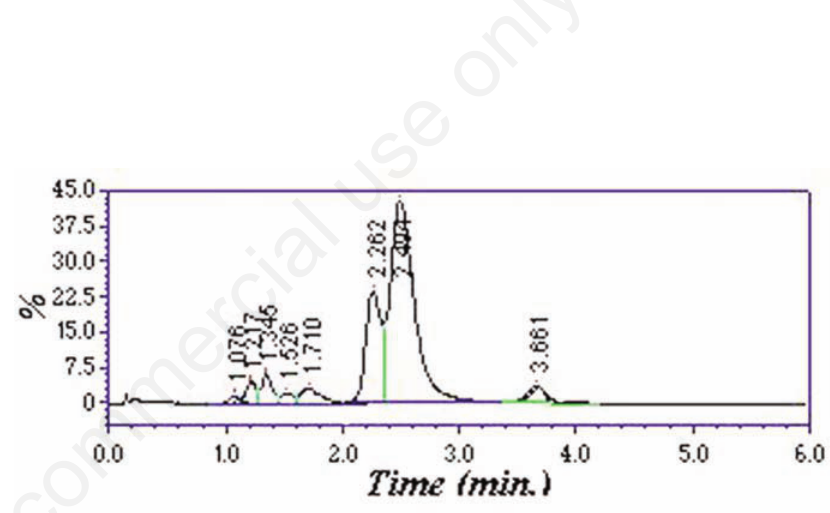
Figure 1. Hemoglobin Grange-Blanche electropherogram.